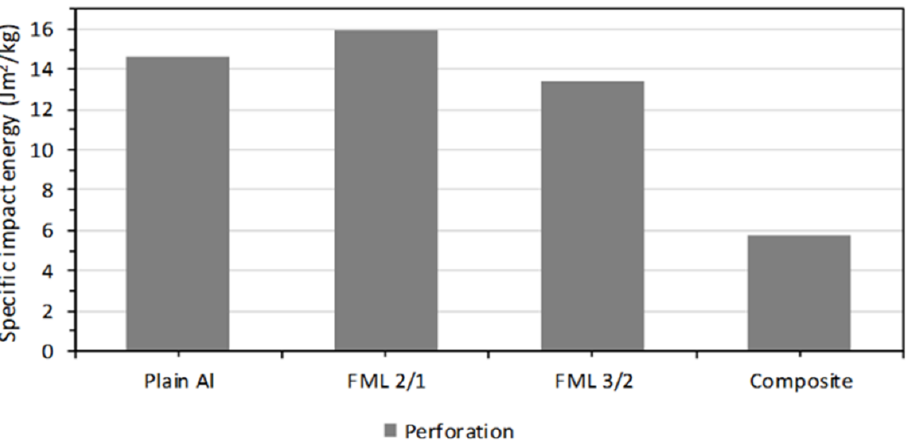
Figure 14. Specific impact perforation energies on the FMLs and the constituent materials.